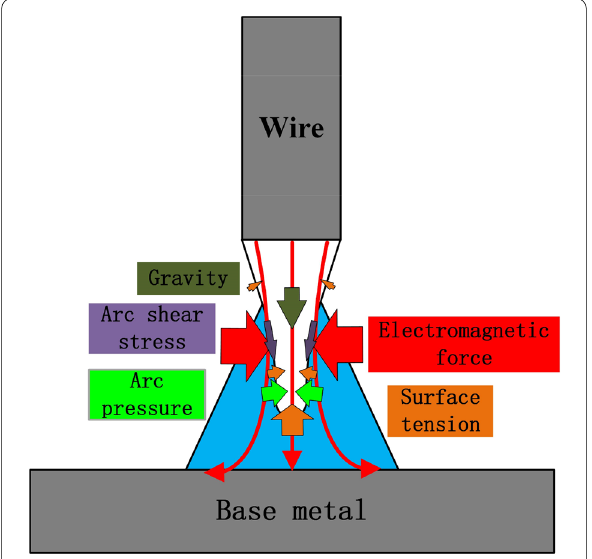
Figure 2 The main acting forces in the metal liquid column of GMAW spray transfer